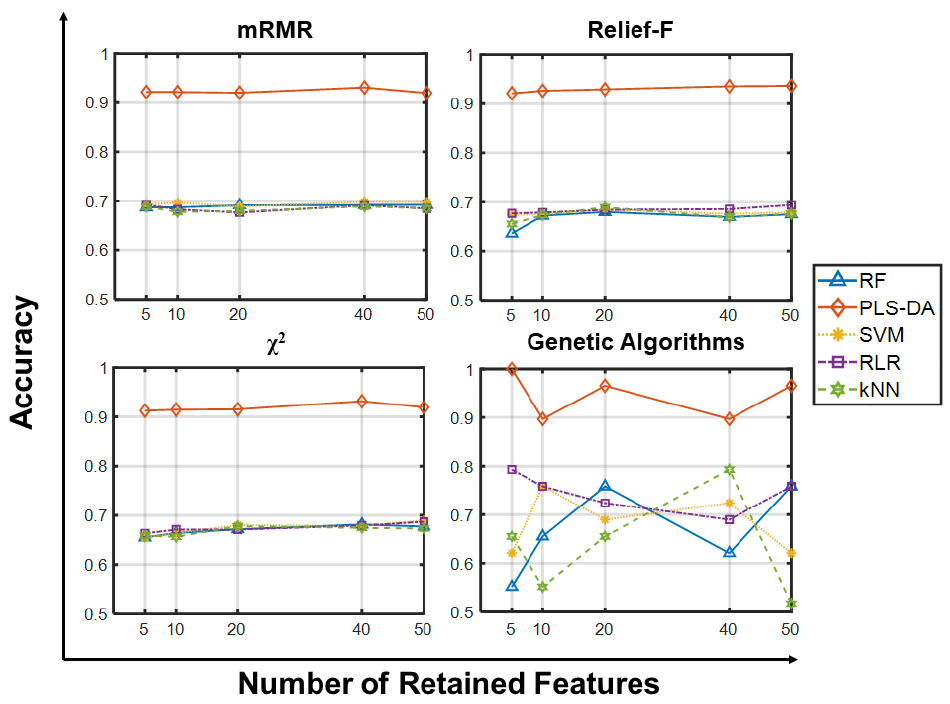
Figure 1. Predictive accuracy using few retained features on SMK_CAN_187. Predictive accuracies of the classifiers (RF, PLS-DA, SVM, RLR, kNN) vs. Number of Retained Features (5, 10, 20, 40, 50) on the SMK_CAN_187 dataset using the four feature selection methods. Each point in the panels for mRMR, Relief-F and Chi-squared is the average predictive accuracy computed over 100 resamplings, while those for GA corresponds to a single